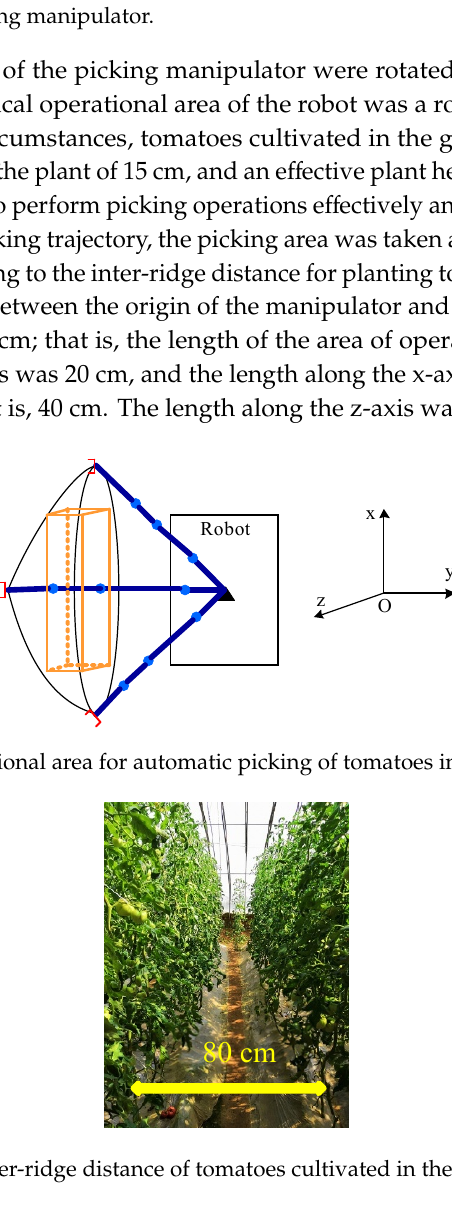
Figure 3. Lifting platform required by robots to pick tomatoes at different stages of maturity. 1. Chassis; 2. Lifting platform; 3. Picking manipulator.